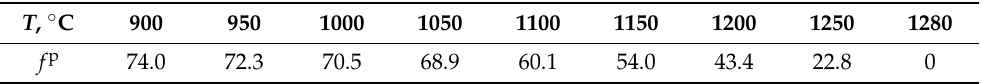
Table 1. The γ (cid:48) -volume fraction f p as a function of temperature, vol. %. T , ◦